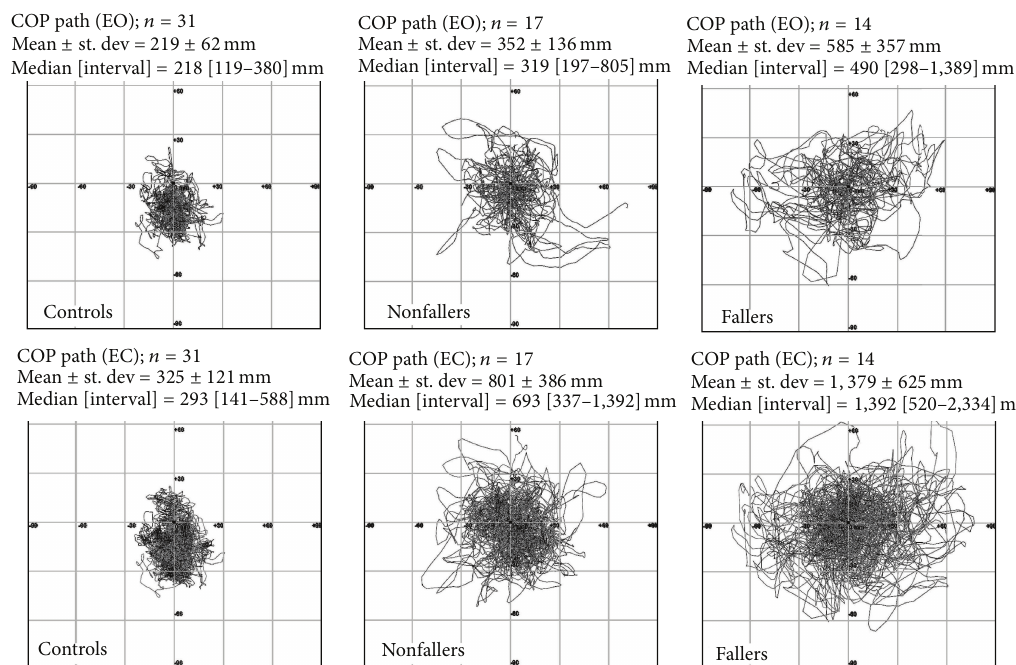
Figure 1: Superimposed displacements of centre of pressure (COP path) on 𝑥 - 𝑦 -axes with both eyes opened (EO) and closed (EC) (upper and lower rows, resp.) of healthy volunteers (controls, n =31), patients without a history of falls (nonfallers, n =17), and those reporting one or more falls in the past 6 months (fallers, n =14) (modified from